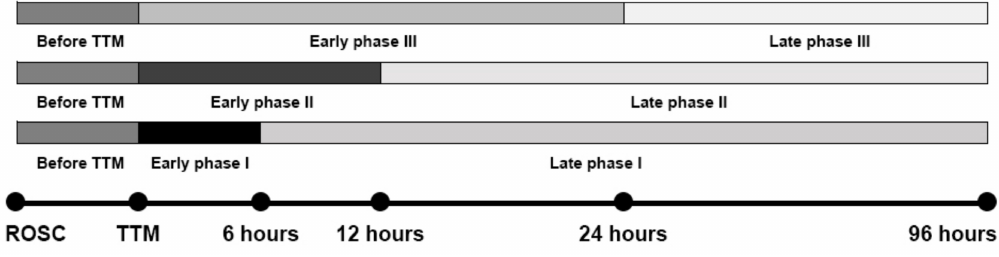
Figure 2. Time frame for the timing of hypotension episodes after out-of-hospital cardiac arrest. Basic demographic variables, resuscitation variables, and postresuscitation variables were